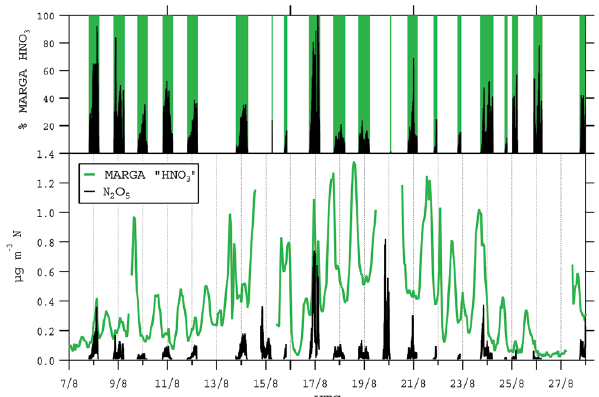
Fig. 1. Bottom panel: time series of N 2 O 5 measured by CRDS and “HNO 3 ” measured by MARGA during August 2012 from the Taunus observatory, Kleiner Feldberg, Germany. Top panel: noctur- nal contribution of measured N 2 O 5 to the MARGA HNO 3 signal and the calculated remaining contribution of HNO 3 when data was measured concurrently. There was no N 2 O 5 data available on the night of the 13 August and partial data available on the nights of the 14/22/23